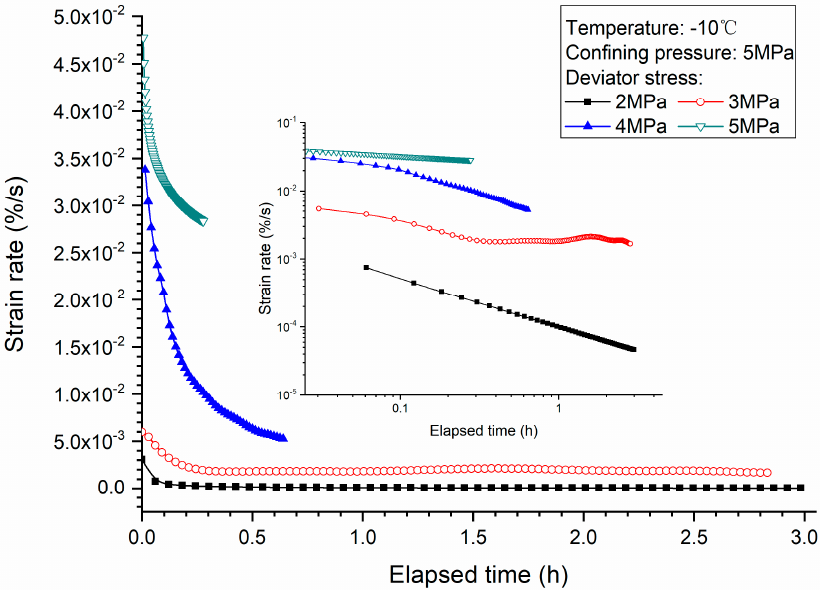
Figure 6. Creep strain rate versus elapsed time for methane hydrate-bearing frozen specimens under high deviator stresses.